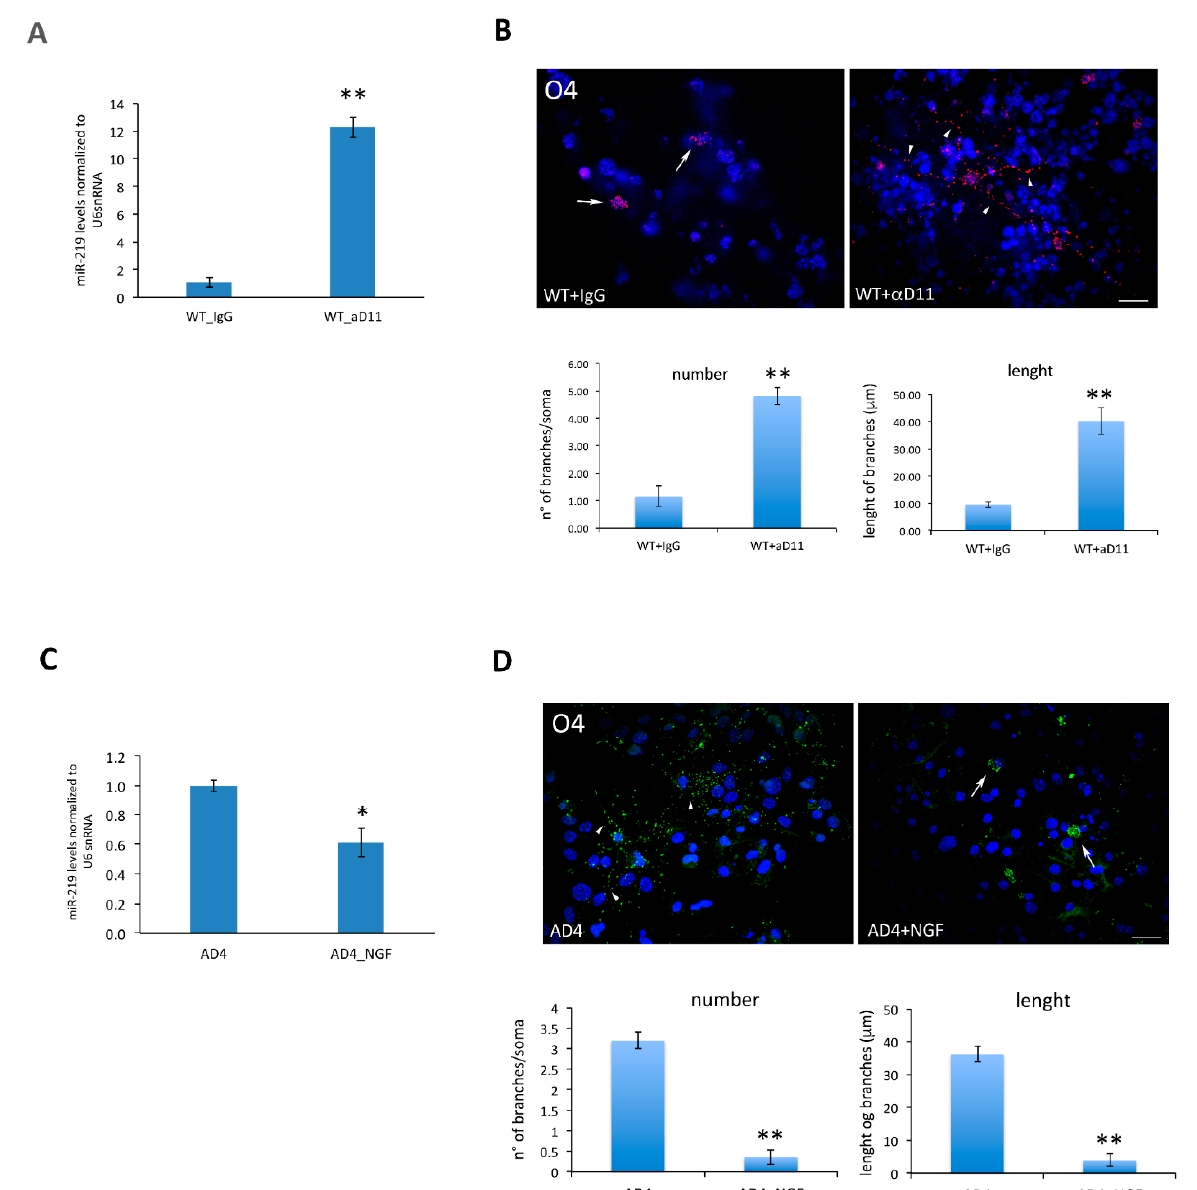
Figure 7. Modulation of miR-219 is NGF-dependent. ( A ) NGF neutralization in WT cells, by treatment with the anti-NGF α D11 antibody, induces a significant increase in miR-219 levels, which is not observed in control IgG-treated cells. The histogram reports qRT-PCR results of miR-219 levels measured in WT cells treated with α D11 or IgG as control ( n = 3). ( B ): Representative immunofluorescence images for O4, showing enhanced differentiation of anti-NGF-treated WT oligodendrocytes ( α D11) compared to IgG-treated WT oligodendrocytes, in terms of number and length of branches, as quantified in the histograms (lower panel). Nuclei labeled with DAPI are in blue. Scale bar, 10 µm, 20× magnification. ( A , B ) Statistical significance is calculated relative to the WT + IgG sample. Data are expressed as the mean ± standard error (SEM) ( C ): NGF treatment (45 min. long) of AD4 progenitors induces a down-regulation of miR-219 levels. qRT-PCR results are reported as ratio between miR-219 levels measured in treated versus untreated AD4 cells ( n = 4). ( D ): Chronic NGF treatment reduces OL differentiation. Immunofluorescence for O4 shows less differentiated OL in NGF-treated AD4 cultures, compared to untreated cells. Scale bar, 10 µm, 20× magnification. The results were quantified (lower panel) both in terms of branch number and length ( n ≥ 20 O4+ cells for each condition). ( C , D ) Statistical significance is calculated relative to the AD4 untreated sample. The data are expressed as the mean ± standard error (SEM)). Student’s t -test: * p < 0.05, ** p < 0.01. ( B , D ). Branch length is highlighted with arrows (short branches) or arrowheads (long branches).